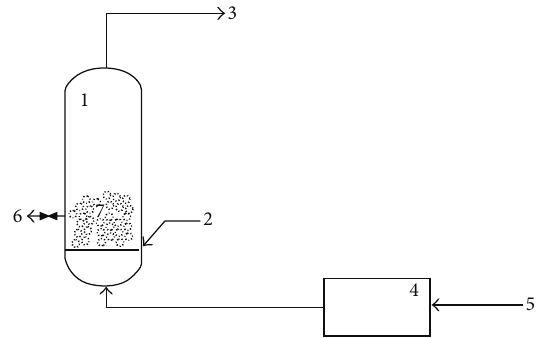
Figure 1: Schematic of the apparatus for the ozonation reaction. (1) Upflow glass bubble column reactor. (2) Porous glass (gas diffuser). (3) Pacific Technology D412 ozone destroyer. (4) Ozone